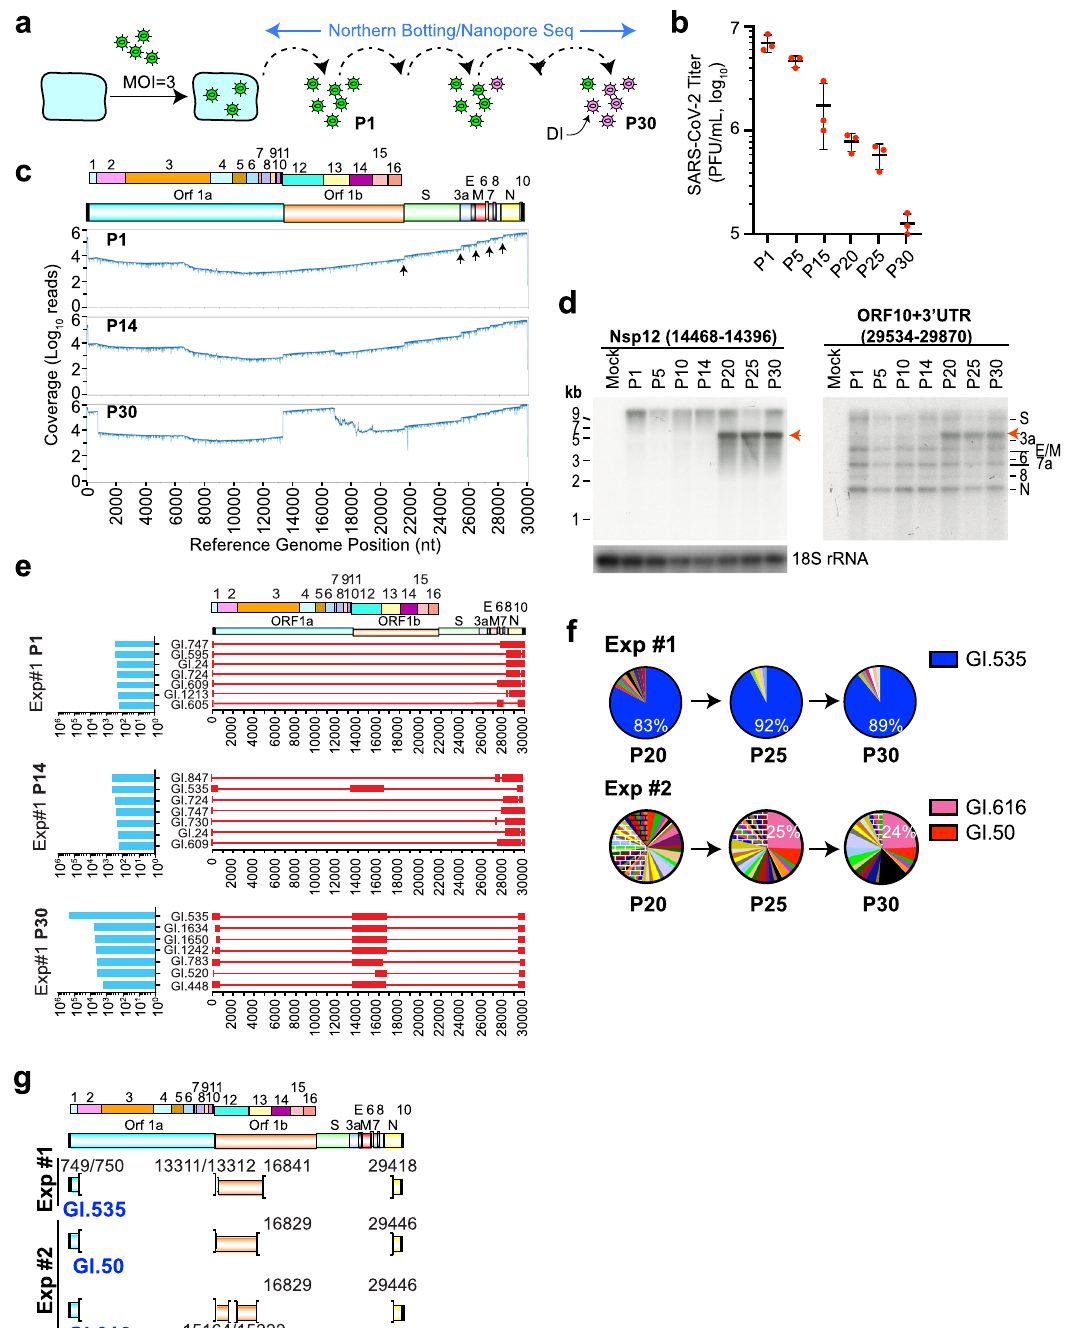
Fig. 1 Emergence of SARS-CoV-2 DI particles upon serial passaging in Vero E6 cells. a Strategy used to isolate SARS-CoV-2 DIs. Northern blotting and nanopore DRS were used to assess the emergence of prominent DVGs during serial passaging. Parental virus particles are shown in green and emerging DIs in magenta. b Quantitation of virus titers obtained from the indicated passages. n = 3 biologically independent experiments ± SD. c Genome coverage of nanopore RNA sequencing data from P1, P14, and P30. The “ step ” changes (indicated by upward arrows in P1) occur at the 5 ′ borders of the S, 3a, E, 6, and N sgRNAs. The reference genome position (nt) is shown at the bottom. d Northern blot analysis performed on RNA isolated from the indicated passages of SARS-CoV-2-infected cells. Red arrow highlights prominent DVGs emerging at late passages. Mock, uninfected cells. Probe identity is indicated above the blots. e Architecture of the top seven most abundant DVGs obtained from P1, P14, and P30-infected cells from Exp #1 having retained 5 ′ and 3 ′ end sequences. Right: DVG architecture. Open red boxes are retained sequences and thin lines correspond to deletions. Left: Read counts corresponding to the transcript model. The SARS-CoV-2 reference genome is shown at the top, along with the encoded polypeptides. Nucleotide position of the reference genome is provided below. f Pie chart illustrating relative abundance of DVGs in P20, P25, and P30 from Exp #1 and Exp #2. g Genome architecture of the most prevalent DVGs isolated from infected cells at P30. Nucleotide position is based on the SARS-CoV-2 Wuhan-Hu-1 isolate (NC_045512.2).